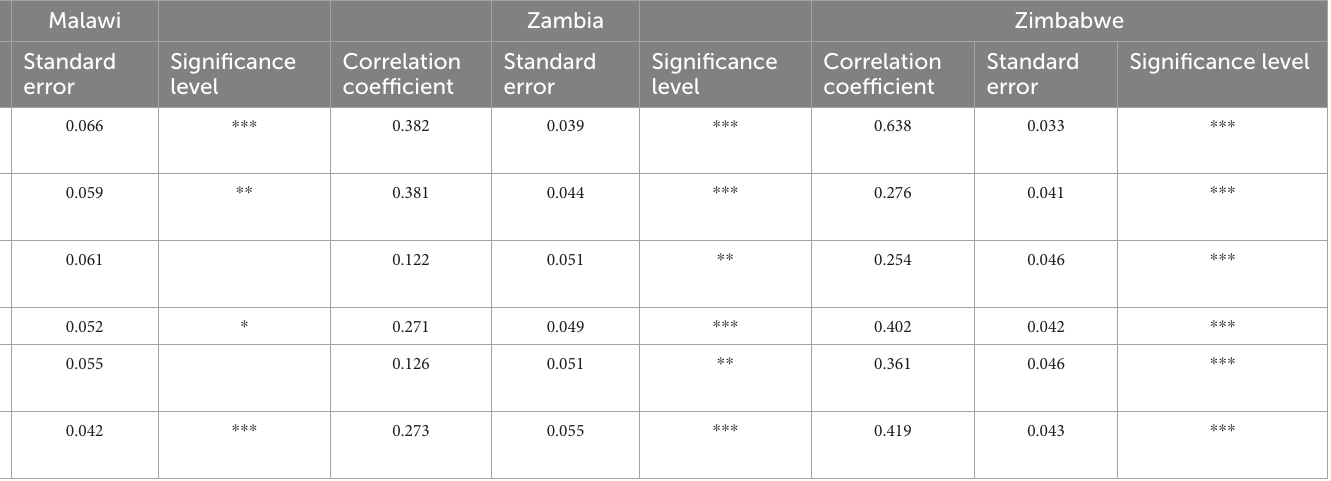
TABLE 11 Correlation coefficients of error terms obtained from multivariate probit model